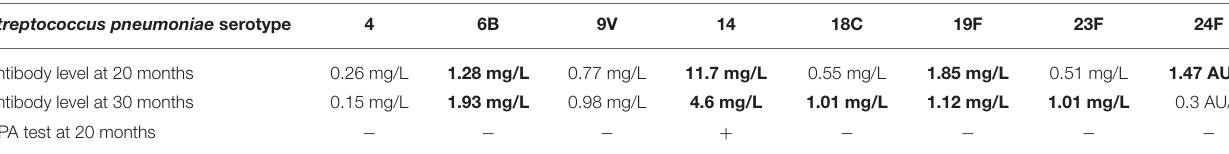
TABLE 1 | Specific evaluation of antibodies against pneumococcal capsular polysaccharide in serum. Streptococcus pneumoniae